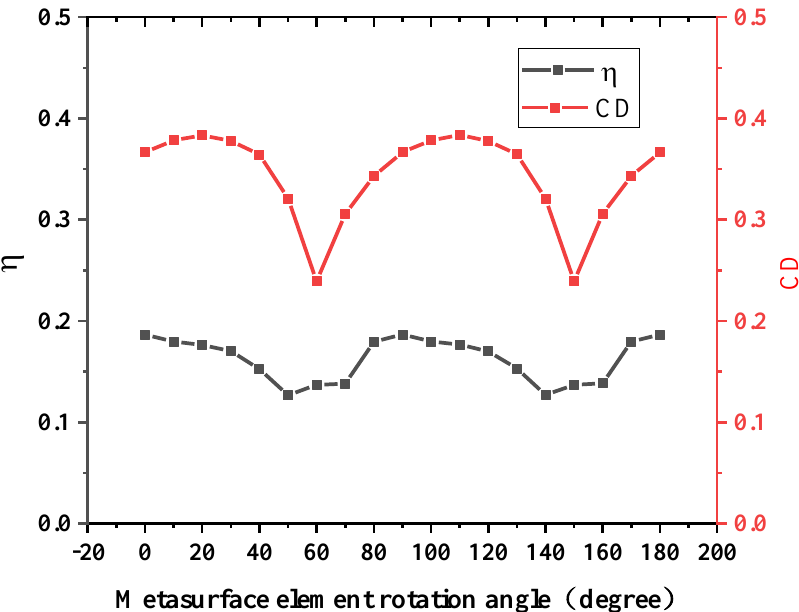
Figure 6. The trend of ellipticity and circular dichroism for large-angle rotations of the metasurface.